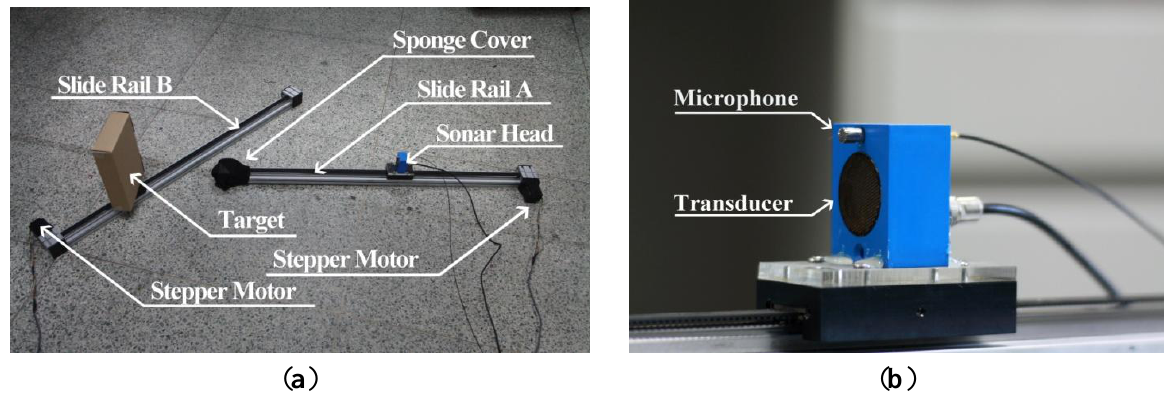
Figure 6. Pictures of the experimental apparatus. ( a ) The entire motion system;